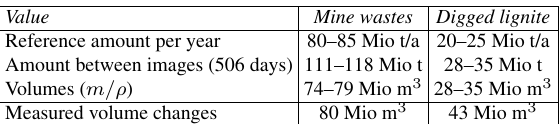
Figure 6: Volume changes between the WorldView-2 and GeoEye scene, small section 1100 m × 450 m, top left: newly erected building, bottom right: cut down forest In the left bottom edge of fig. 5 the open pit mining area “Braun- kohletagebau Inden” is visible. A positive or negative height change from any kind of vegetation to non-vegetation allows us to calculate the mined volumes. For this the positive (green) and negative (red) volumes of fig. 5 are calculated as 79.87 and 122.76 millions of cubic metres. The negative changes are the whole digged out volume containing the lignite and also the mine wastes. The positive changes are however only the dumped mine wastes. The mine wastes consist only of earth and stone with a density of ρ = 1500 kg/m 3 while the lignite has a density of soil ρ = 1000 kg/m 3 . This allows us to convert the volume lignite changes to mass changes as shown in tab. 2. Table 2: Validation of 3D change detection results for the open- cast mining Inden (left bottom mining area); reference data from http://de.wikipedia.org/wiki/Tagebau